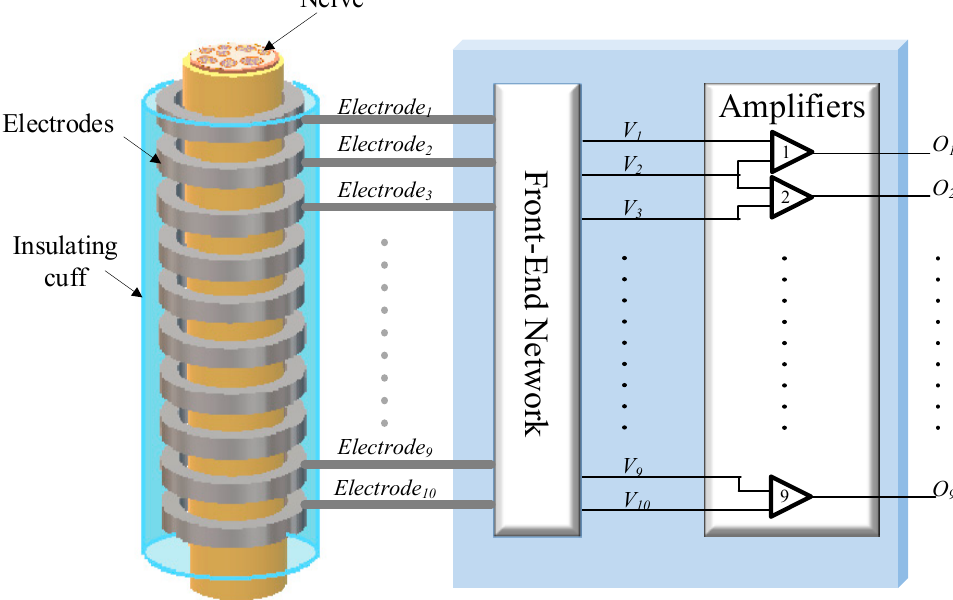
Figure 1. Simplified schematic of a typical recording configuration using a MEC fitted to a peripheral nerve. There may be one or more ranks of amplification after the front-end network.